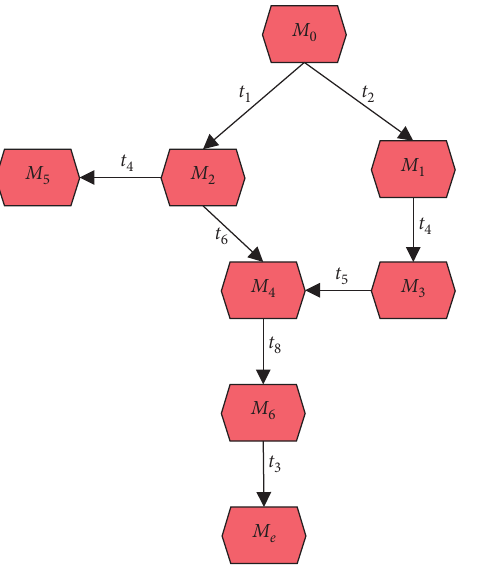
Figure 5: Reduced state space of